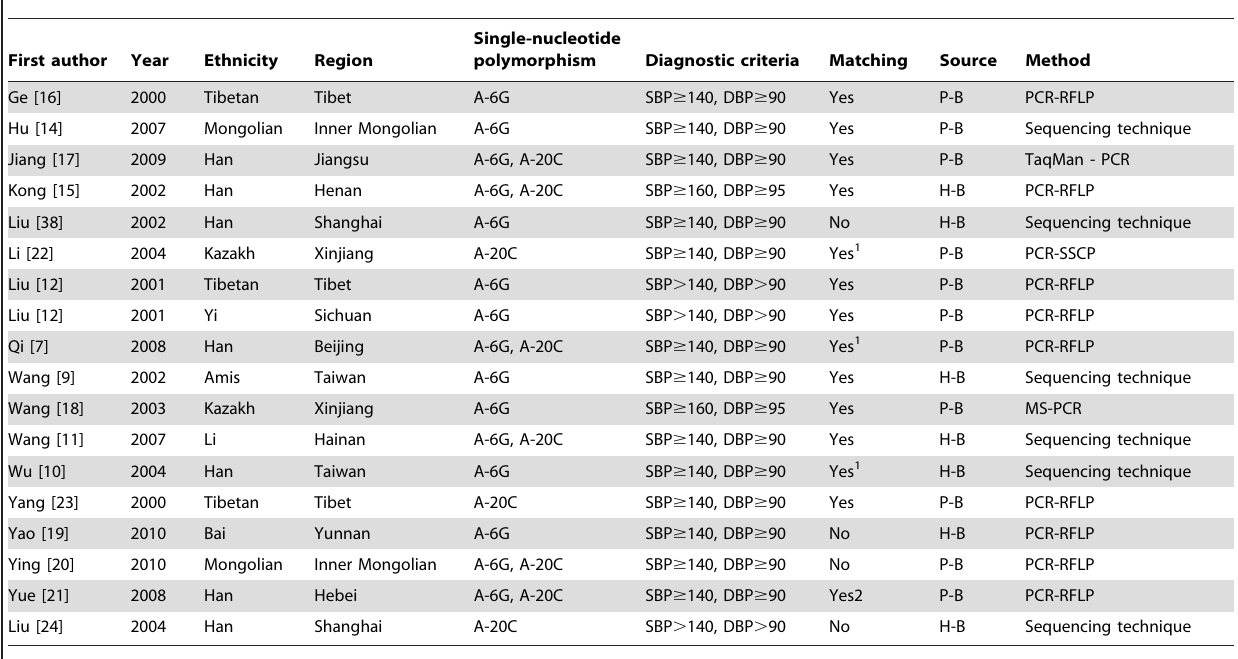
Table 1. Detailed characteristics of eligible studies considered in the meta-analysis.